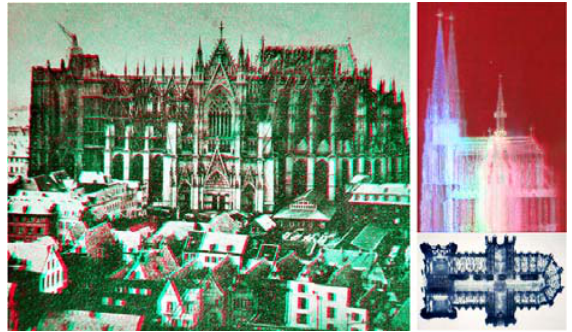
Figure 2. The eldest stereo view (approx. from 1856) of the famous Cologne Cathedral (Germany), even showing remaining cranes of the middle age and the towers are still incomplete, presented in color anaglyphs, in comparison with a modern lasered crystal showing the Cologne Cathedral in 3D and an oblique situation plan of the crystal (photographs by the authors, use anaglyph glasses!)